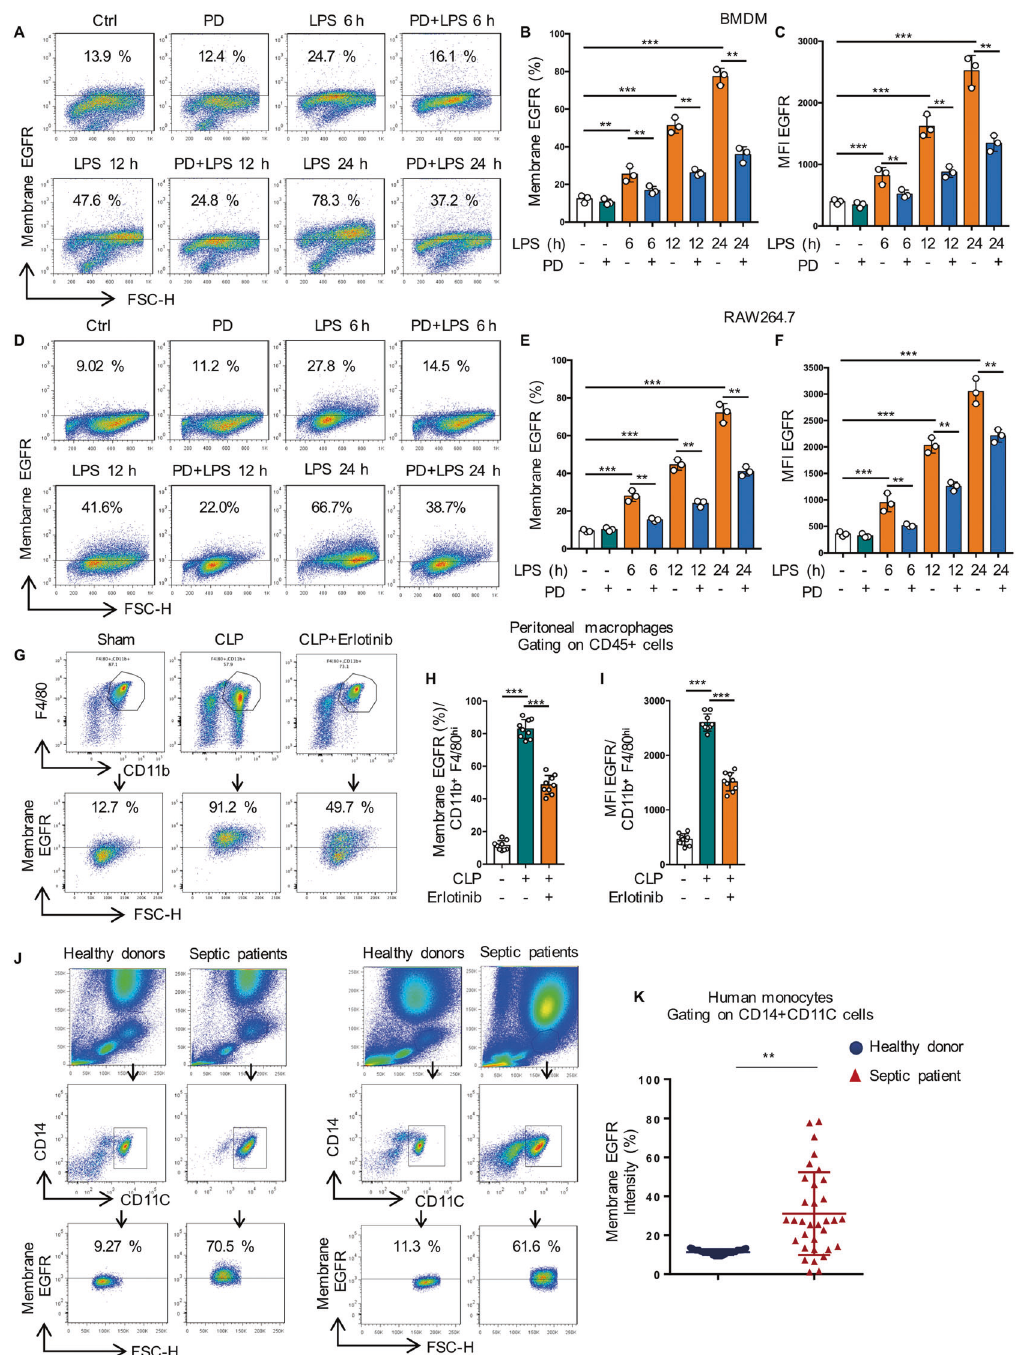
Fig. 1 LPS promotes cell surface expression of EGFR in macrophage. A – F Macrophages were treated with LPS (1 µg/mL) for 6, 12, or 24 h with or without PD168393 (PD, 10 µM)) pretreatment for 30 min. A Flow cytometry analysis of EGFR cell surface expression in BMDM. B Percentage of EGFR-positive macrophage is shown. C Mean fl uorescence intensity (MFI) is shown ( n = 3). D Flow cytometry analysis of EGFR cell surface expression in RAW264.7. E Percentage of EGFR-positive macrophage is shown. F Mean fl uorescence intensity (MFI) is shown ( n = 3). G – I Macrophages were collected from peritoneal lavage of C57BL/6 mice subjected to CLP and were divided into Sham-operated, CLP and CLP plus Erlotinib (100 mg/kg, gavage) pretreatmend for 2 h, and peritoneal macrophages were identi fi ed with CD45 + CD11b + F4/ 80high. G EGFR intensity on the surface of peritoneal macrophage was analyzed by fl ow cytometry. H Percentage of EGFR-positive peritoneal macrophage is shown ( n = 9). I Mean fl uorescence intensity (MFI) is shown ( n = 9). J , K Blood was collected from patients with clinical sepsis or health donors, and blood mononuclear cells were identi fi ed with CD14 and CD11c. J EGFR intensity on the surface of Mononuclear cells were analyzed by fl ow cytometry (20 Healthy donors and 33 Septic patients). K Percentage of EGFR-positive CD14 + CD11c + mononuclear cell is shown. The graphs depict mean ± SD based on three independent experiments. * P < 0.05, ** P < 0.01, *** P < 0.001.